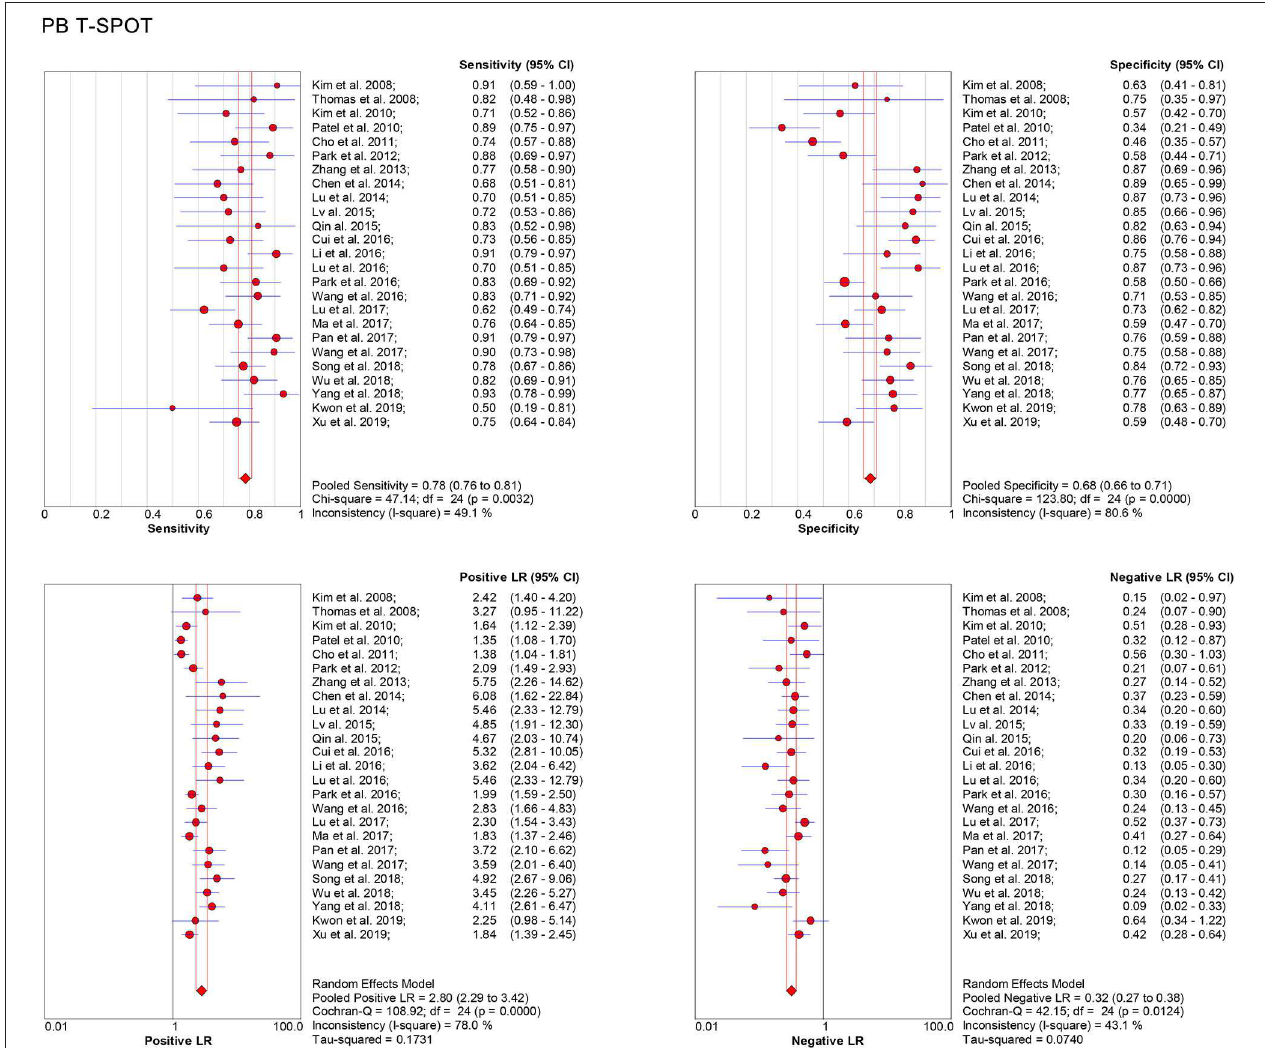
FIGURE 3 | Forest plot showing estimates of sensitivity, specificity, PLR, and NLR for PB T-SPOT for the diagnosis of TBM. Solid dots represent the point estimates of sensitivity, specificity, PLR, and NLR from each study. Size of solid dots reflects the total number of cases and controls. Error bars indicate 95% CI. Pooled results are shown as diamonds. PLR, positive likelihood ratio; NLR, negative likelihood ratio; PB, peripheral blood; TBM, tuberculous meningitis; CI, confidence interval.